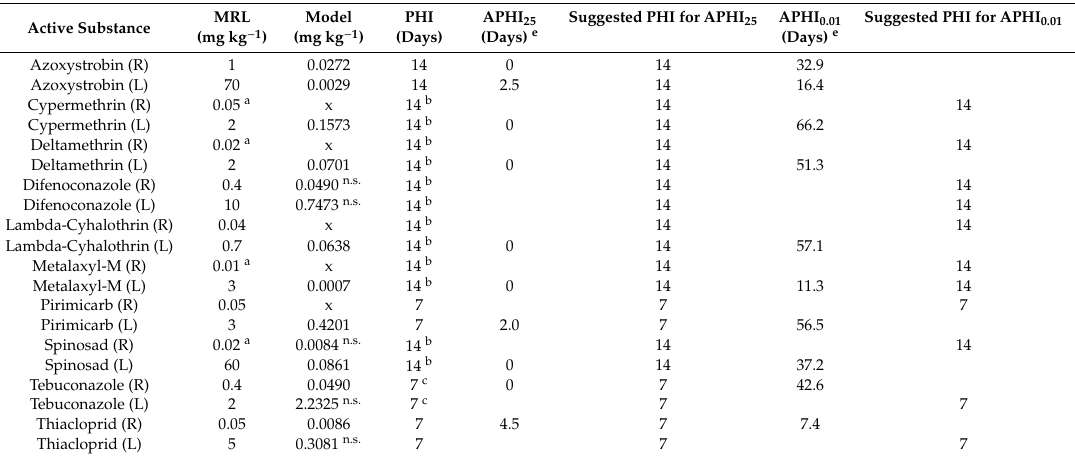
Table 6. Pesticide residues in